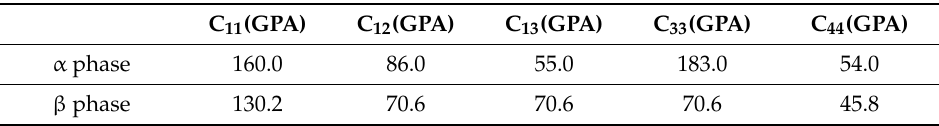
Table 1. Single-crystal elastic constants C ij